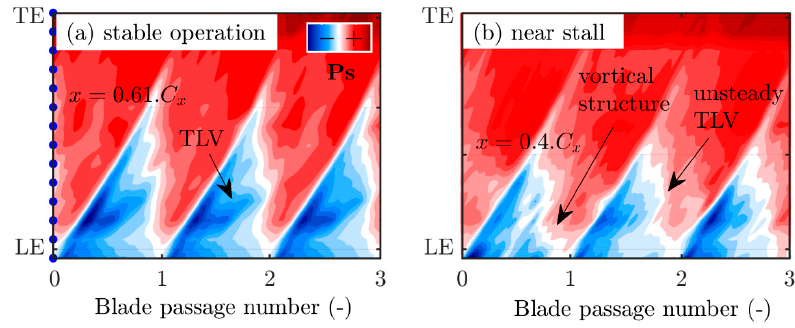
Figure 13. ( a ) Pressure contour during stable operation and ( b ) near stall. θ = 311°. Sensors are represented by blue dots.